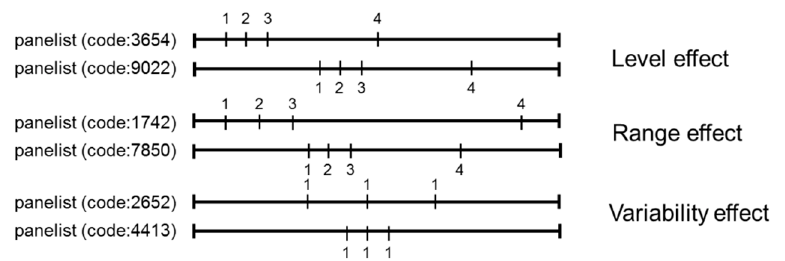
Figure 1. Individual differences in scale usage (based on [13]).